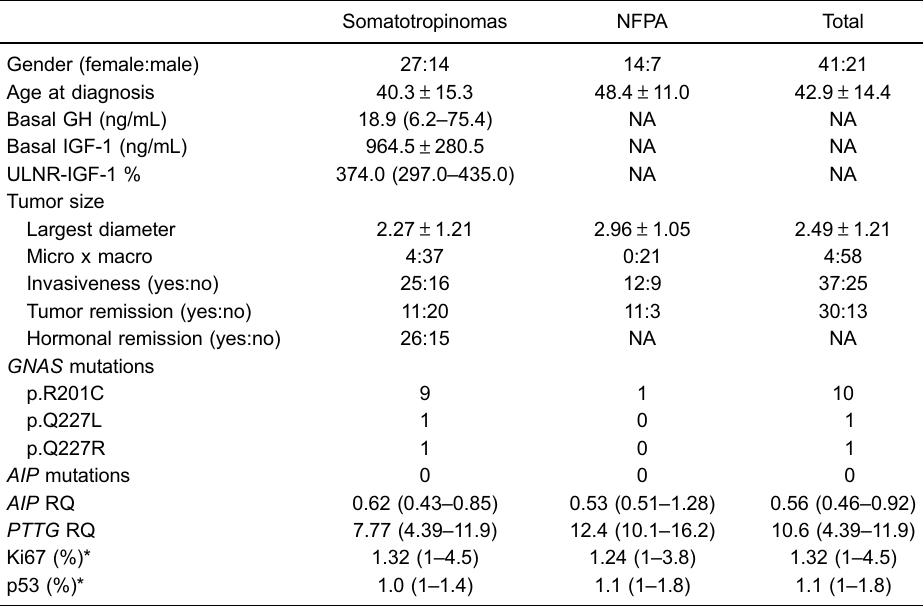
Table 1. Summary of clinical, molecular, and immunohistochemical data of patients with somatotropinomas and non-functioning pituitary adenomas (NFPA) evaluated in this study. Somatotropinomas